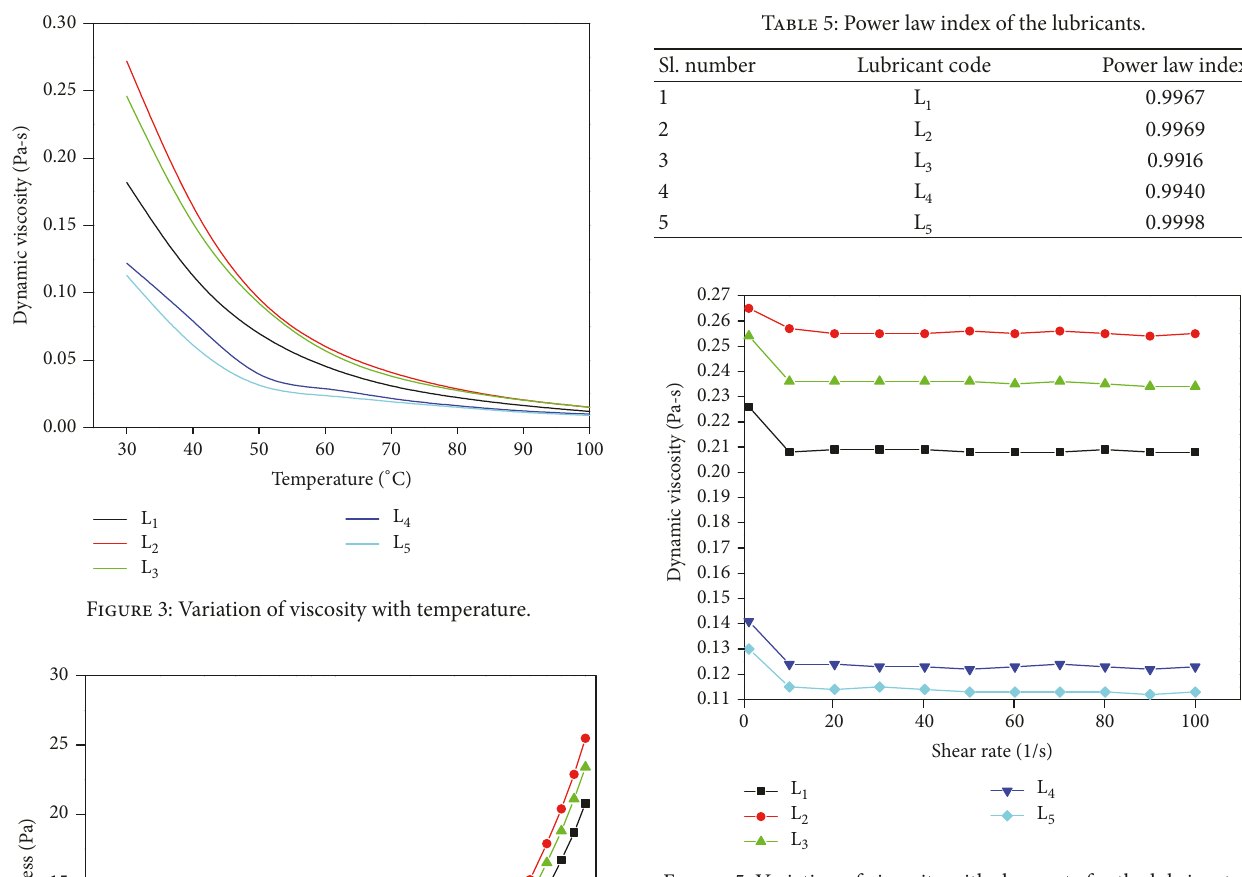
Equation (2) represents the flow behavior of power law